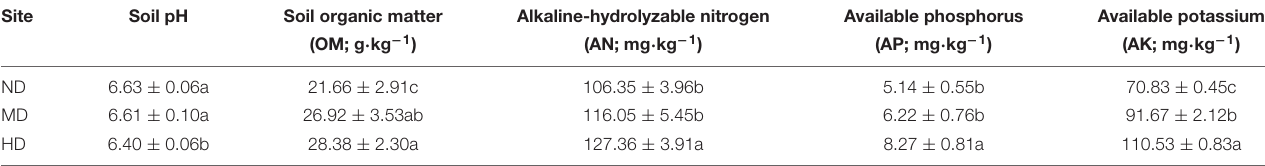
TABLE 2 | Soil physicochemical properties in the three konjac growing sites affected by different levels of soft rot